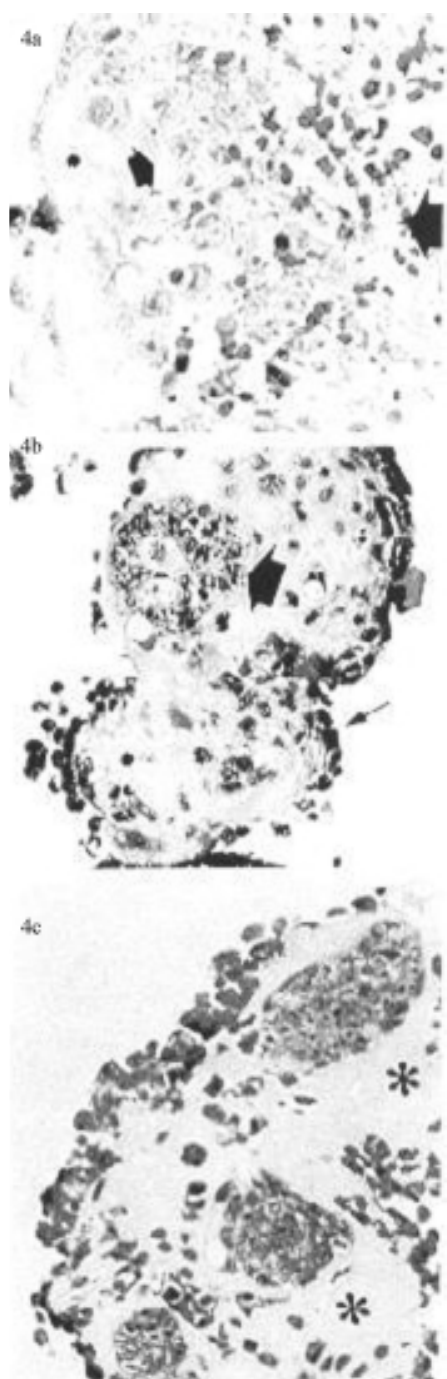
Figure 4 - Light microscopy of Gomori stained sections of nine-day old embryoid bodies derived from the hybrids and HM-1 cells: HM-1 (4a, 1500x). HESS-2 (4b) and HESS-1 (4c) both at 800x magnification. Carti- lagematrix(*),chondroblast-likecells(–),outerlayerofendodermalcells ( ↑ ) and blood cell islands ( (cid:1) ).